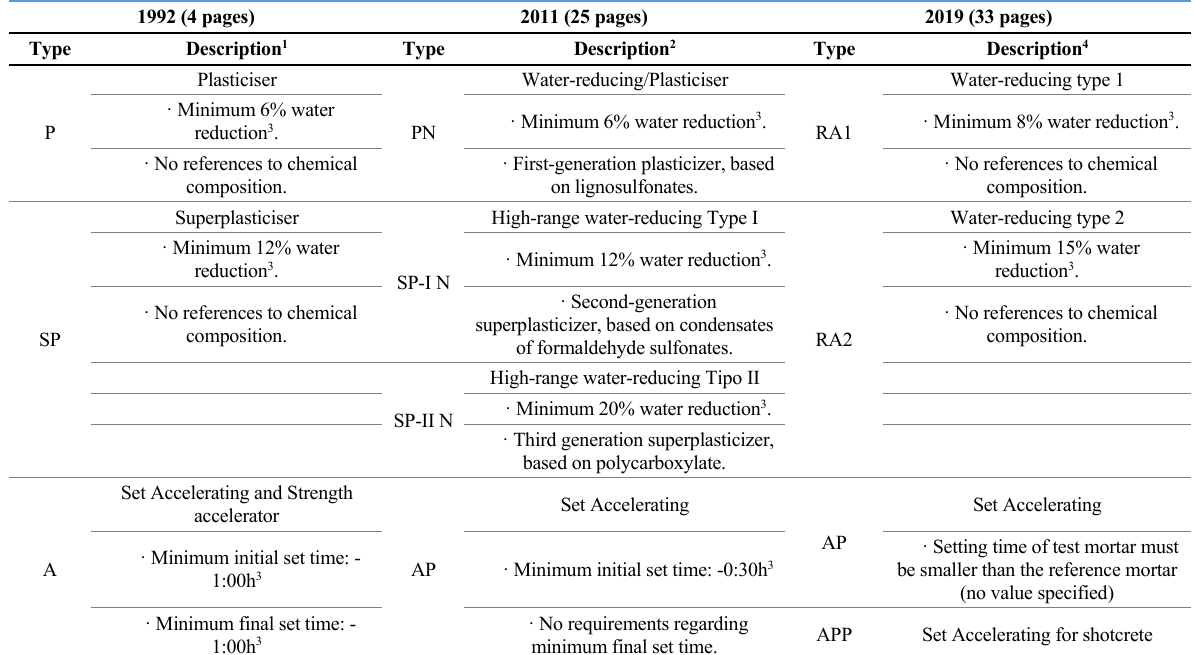
Table 8. Evolution of concrete admixture standards in Brazil and their main